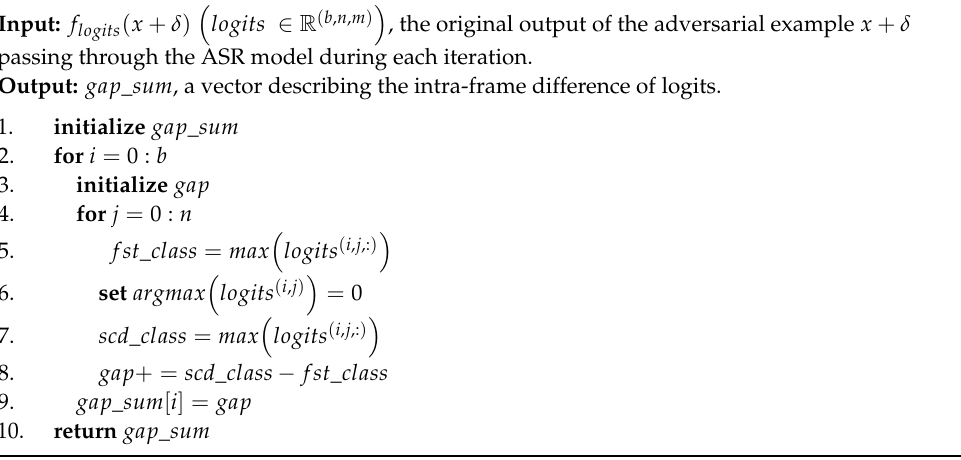
Algorithm 1 : logit _ gap Measurement